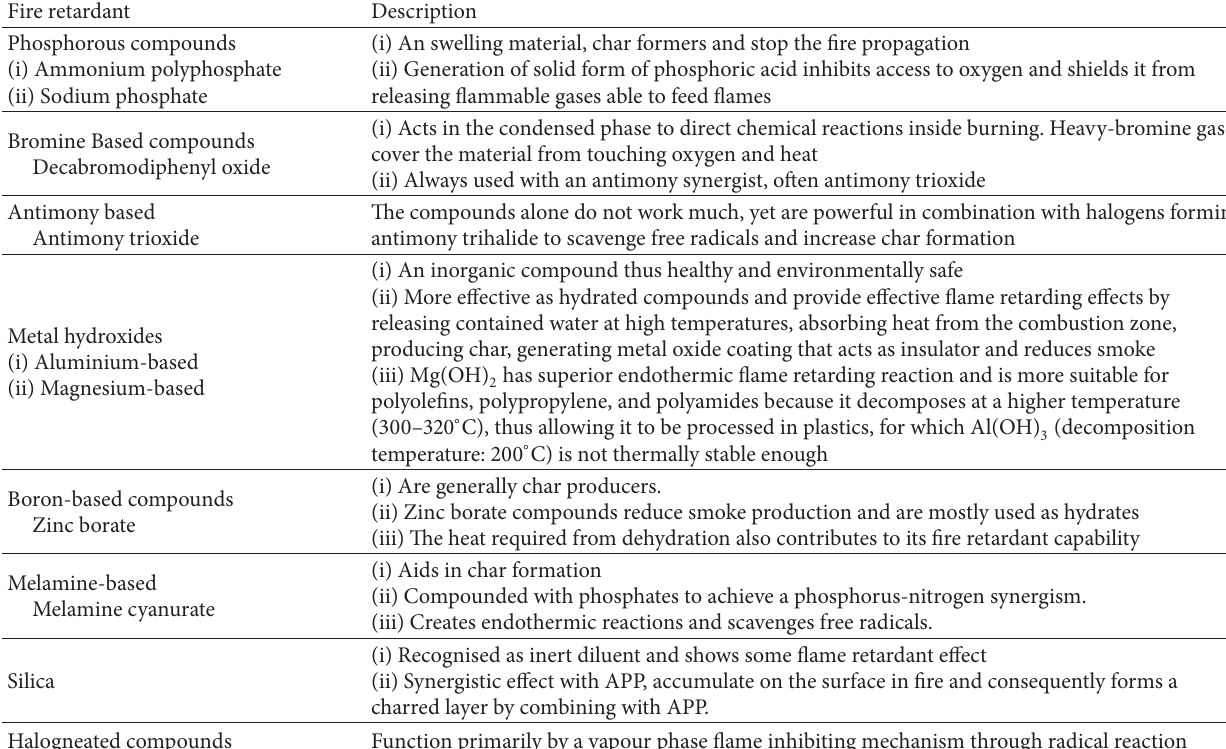
Table 5: Fire retardants and its function [34].